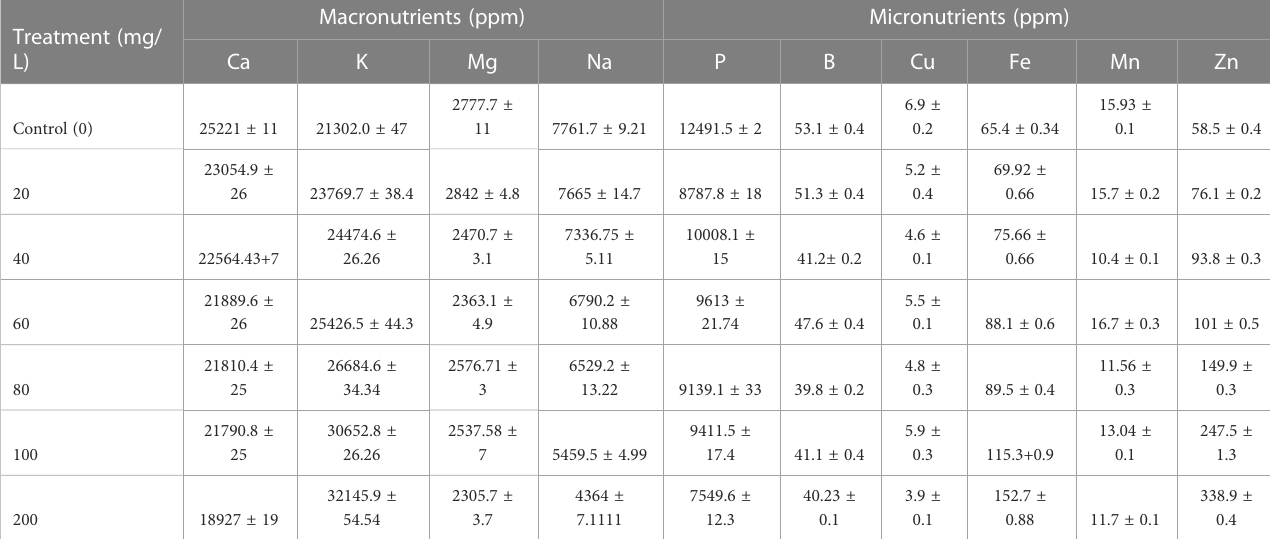
Values are mean ± standard